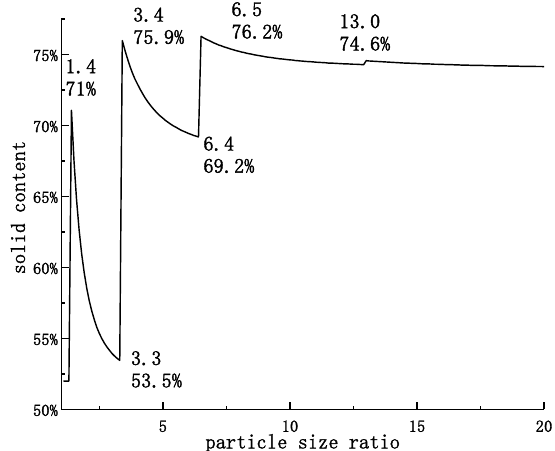
Figure 7. Simulation curve of the particle size ratio–solid content.